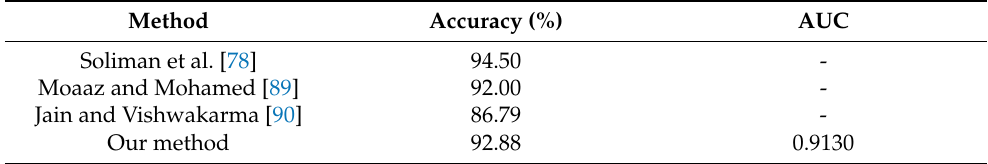
Table 4. Comparison of the proposed method and other previous methods on the RLVS dataset.